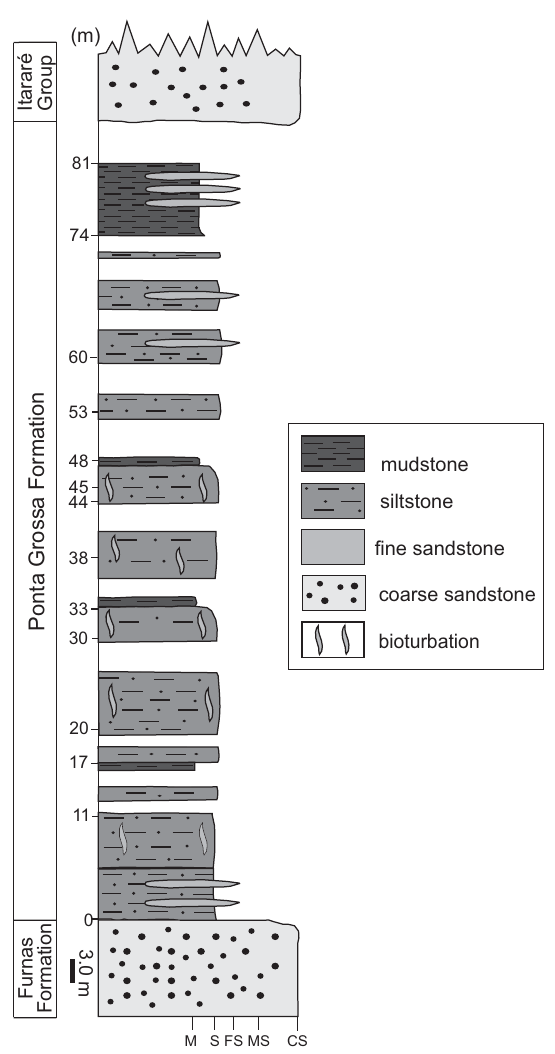
Fig. 3. Measured stratigraphical column of the Ponta Grossa Formation, Jaguariaíva section (from Simões et al. 2009). Abbreviations: M, mud- stone, S, siltstone, FS, fine sandstone, MS, medium sandstone, CS, coarse shallow marine platform settings (Bergamaschi 1999), mainly near or below storm wave base (Simões et al. 2000). Therefore, Clarke’s (1913) material most likely comes from the Jaguariaíva Member, which is composed in part of silt- stone similar in color and texture to the rock matrix hosting his specimens.